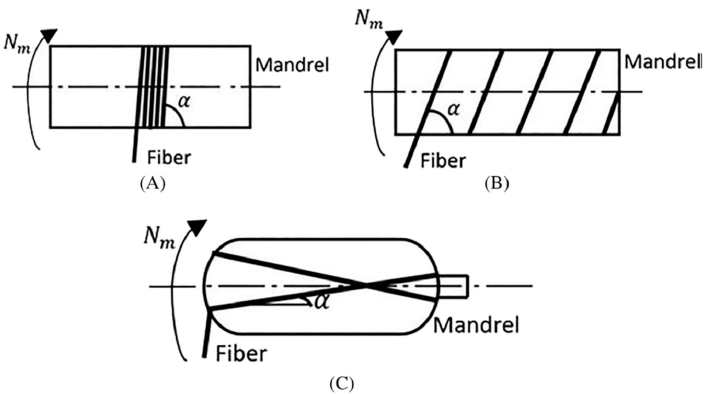
Figure 5. Types of winding patterns; ( A ) hoop; ( B ) helical; ( C ) polar windings [76].